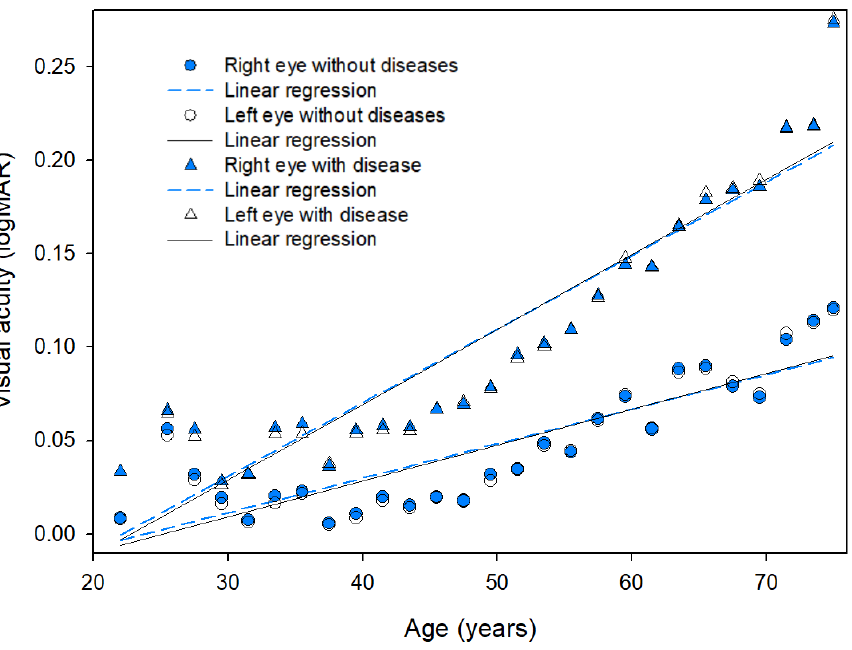
Figure 2. Linear regression for age and mean visual acuity.